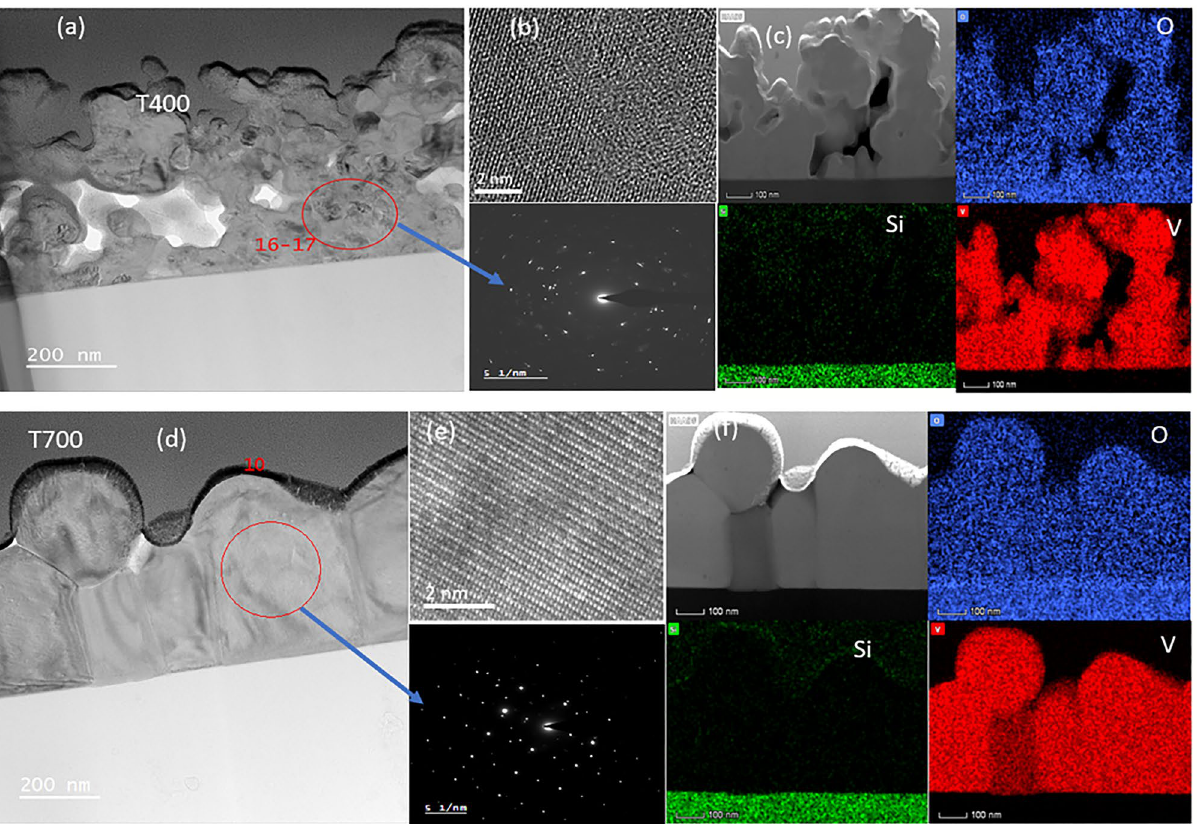
Figure 2. TEM cross-section image of VO 2 thin films deposited onto silica substrates at temperatures of ( a ) 400 °C (VT400) and ( b ) 700 °C (VT700); ( b , e ) corresponding HRTEM and SAED patterns; ( c , f ) EDS chemical mapping obtained during cross-sectional HAADF-STEM analysis of different types of atoms(V, O, and Si).